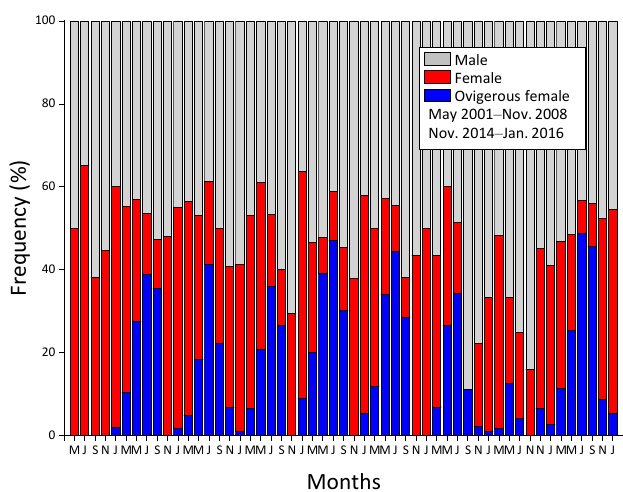
Figure 2. Proportions of all individuals of D. japonicus during the sampling periods.